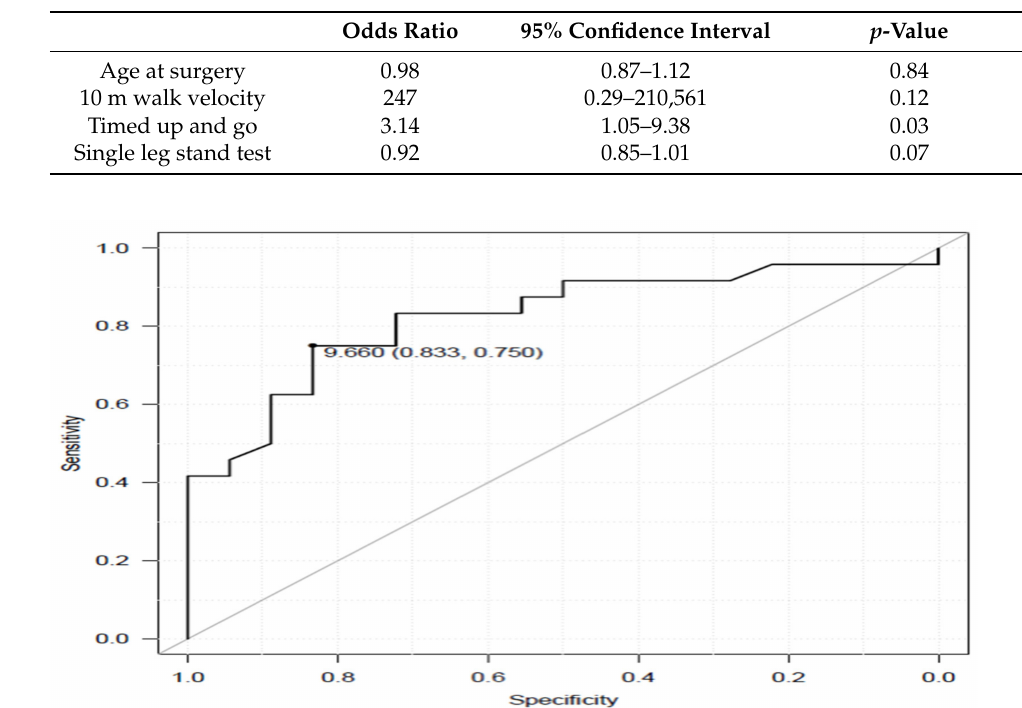
Table 5. Results of logistic regression analysis.